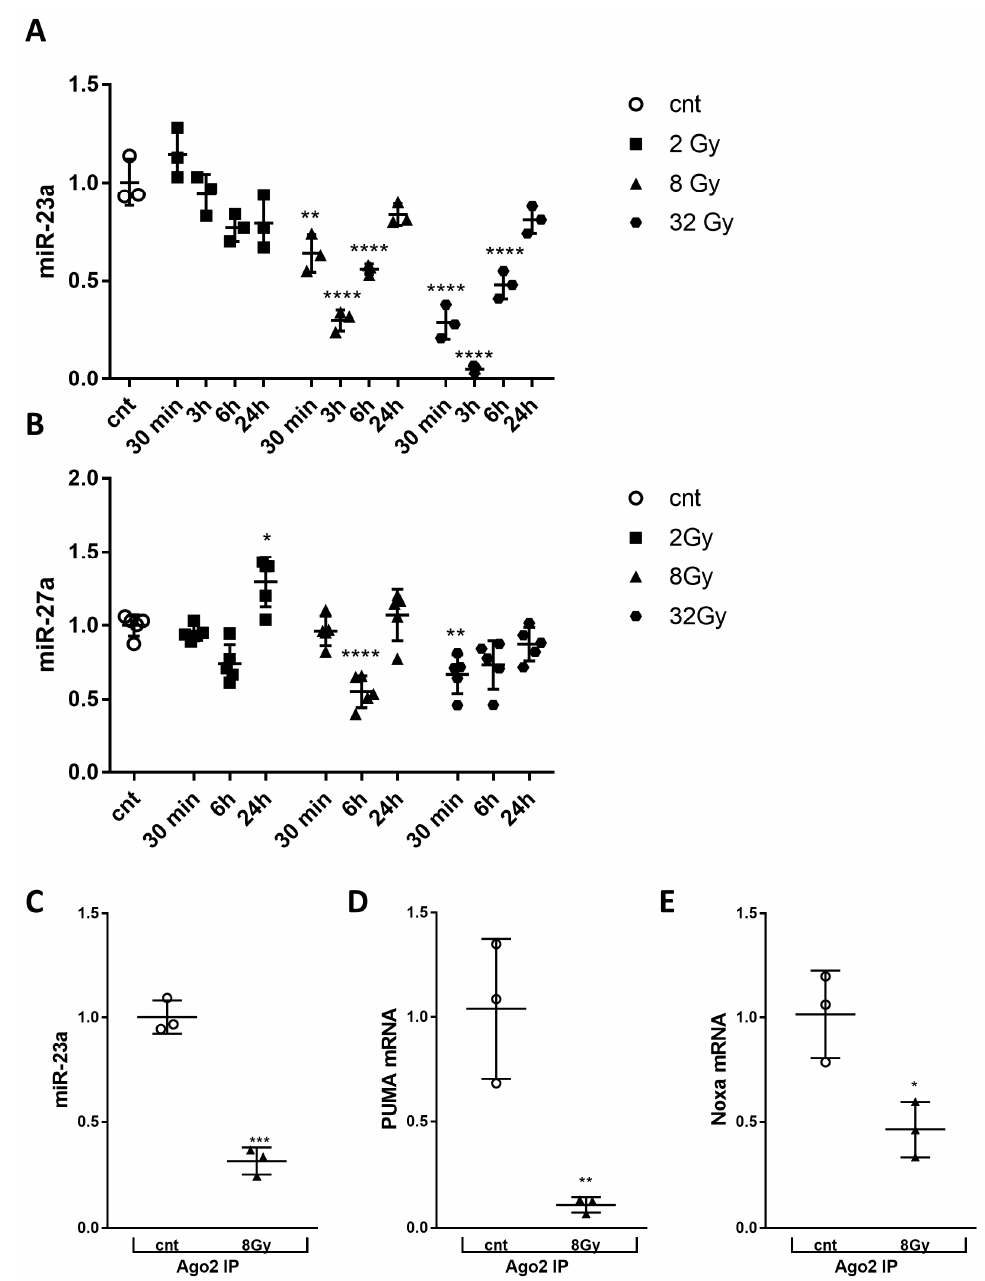
Figure 4. Irradiation decreased levels of cellular miR-23a-3p, and miR-23a-3p, PUMA , and Noxa mRNAs within the RNA-induced silencing complex. Neurons collected at 30 min, 6 h, and 24 h after 2, 8, and 32 Gy irradiation. Total RNA was used for qPCR analysis. qPCR quantification of miR-23a-3p ( A ) and miR-27a-3p ( B ) levels in a representative experiment. The experiment was repeated three times. N = 3 / group in each experiment for miR-23a-3p, n = 5 / group in each experiment for miR-27a-3p, with 2 technical replicates. Data represent the mean ± SD of one-way ANOVA and Tukey post-hoc analysis * p < 0.05, ** p < 0.01, *** p < 0.001, **** p < 0.0001 vs. control RCN. Neurons were collected 3 h after 8 Gy treatment, subjected to RIP with Ago2 antibodies, and samples used for qPCR analysis. qPCR quantification of miR-23a-3p ( C ), Puma ( D ) and Noxa ( E ) levels in precipitates after RIP in a representative experiment. The experiment was repeated two times, n = 3 / group in each experiment with 2 technical replicates. Data represent the mean ± SD. Statistical significance assigned by one-tailed t -test, *** p < 0.001 versus control, n = 3 / group.